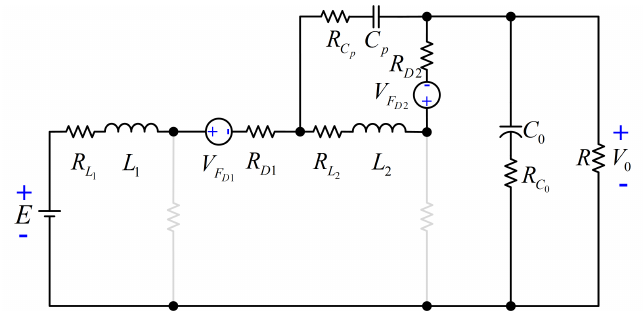
Figure 10. Equivalent circuit for the interval t OFF